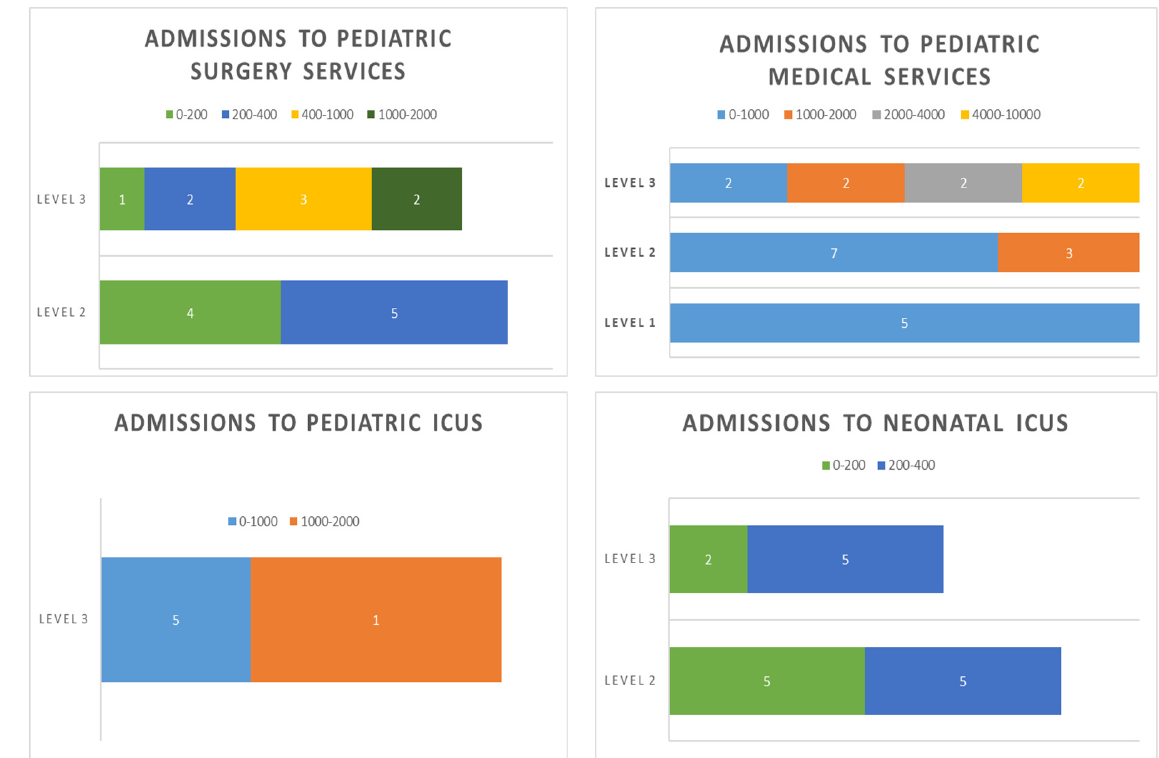
Figure 1. Number of admissions to the hospitals participating in the VINCat pediatric PROA in 2019.